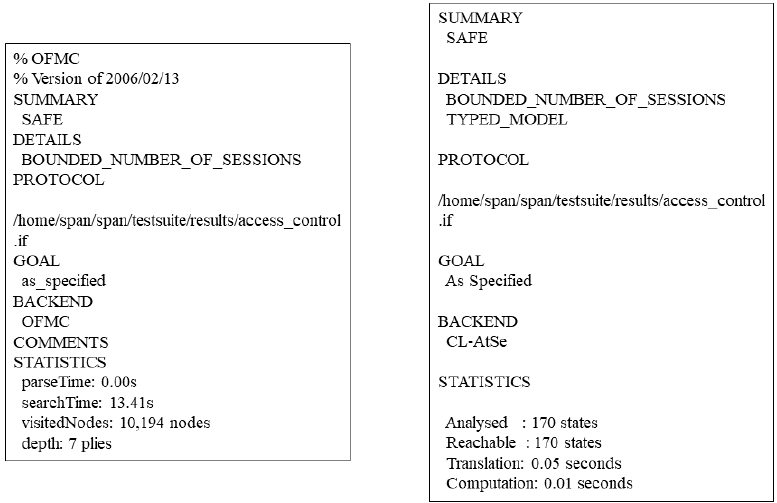
Figure 12. Results of AVISPA’s analysis of the “Access Control Authorization”